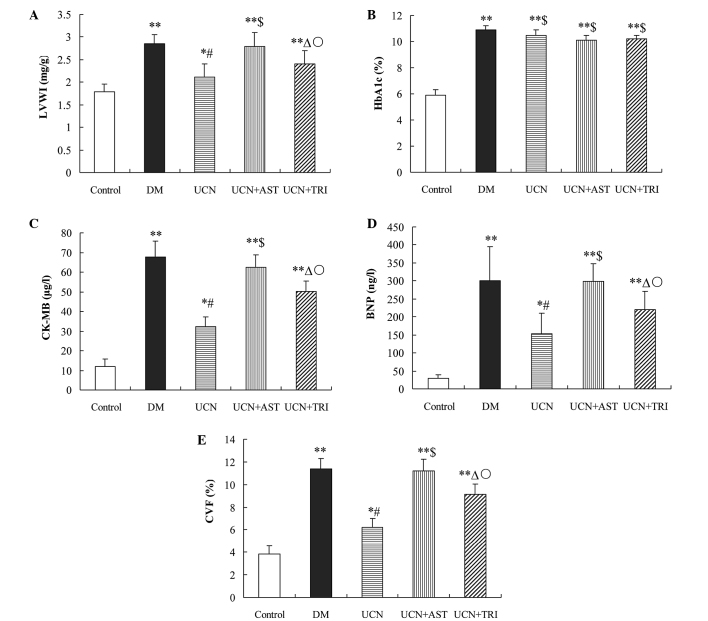
Effect of urocortin on (A) LVWI, (B) HbA1c, (C) CK-MB, (D) BNP and (E) CVF and in the diabetic rats. Levels of BNP and CK-MB, as well as the LVWI and CVF, were decreased by urocortin and urocortin and triciribine treatment, while astressin blunted the effect of urocortin. HbA1c levels were not affected. *P<0.05 and **P<0.01, vs. control; #P<0.01 and ΔP<0.05, vs. DM group and UCN + AST; $P>0.05, vs. DM group; ○P<0.05, vs. UCN group. LVWI, left ventricular mass index; HbAlc, glycosylated hemoglobin; CK-MB, creatine kinase isoenzyme; BNP, brain natriuretic peptide; CVF, collagen fraction volume; DM, diabetes mellutis; UCN, urocortin; AST, astressin.